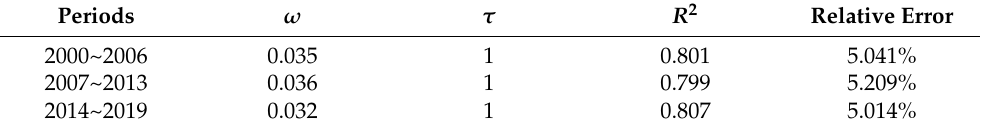
Table 1. Parameters and estimation accuracy of the CO 2 footprints fitting curve.